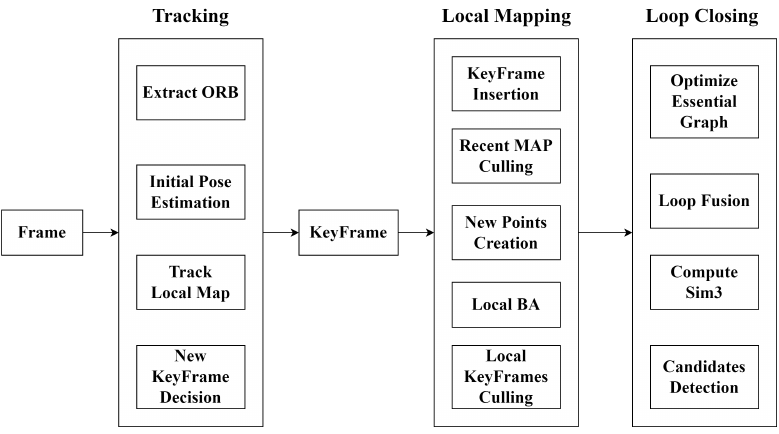
Figure 2. A block diagram of the data flow in the ORB-SLAM